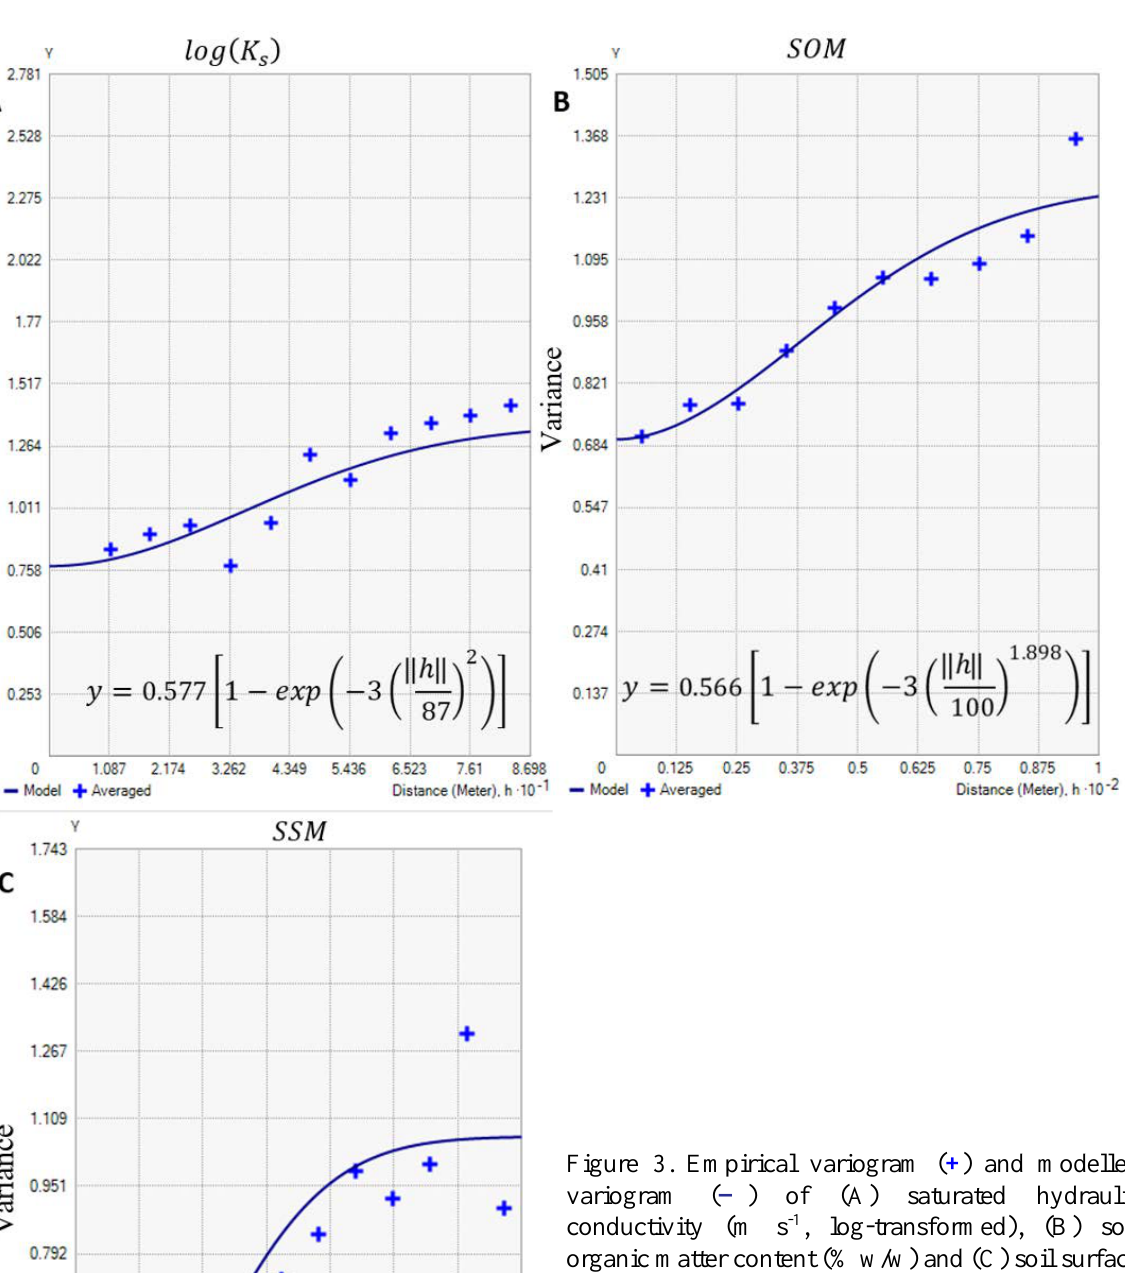
Figure 3. Empirical variogram ( + ) and modelled variogram ( — ) of (A) saturated hydraulic conductivity (m s -1 , log-transformed), (B) soil organic matter content (% w/w) and (C) soil surface microtopography (m above mean sea